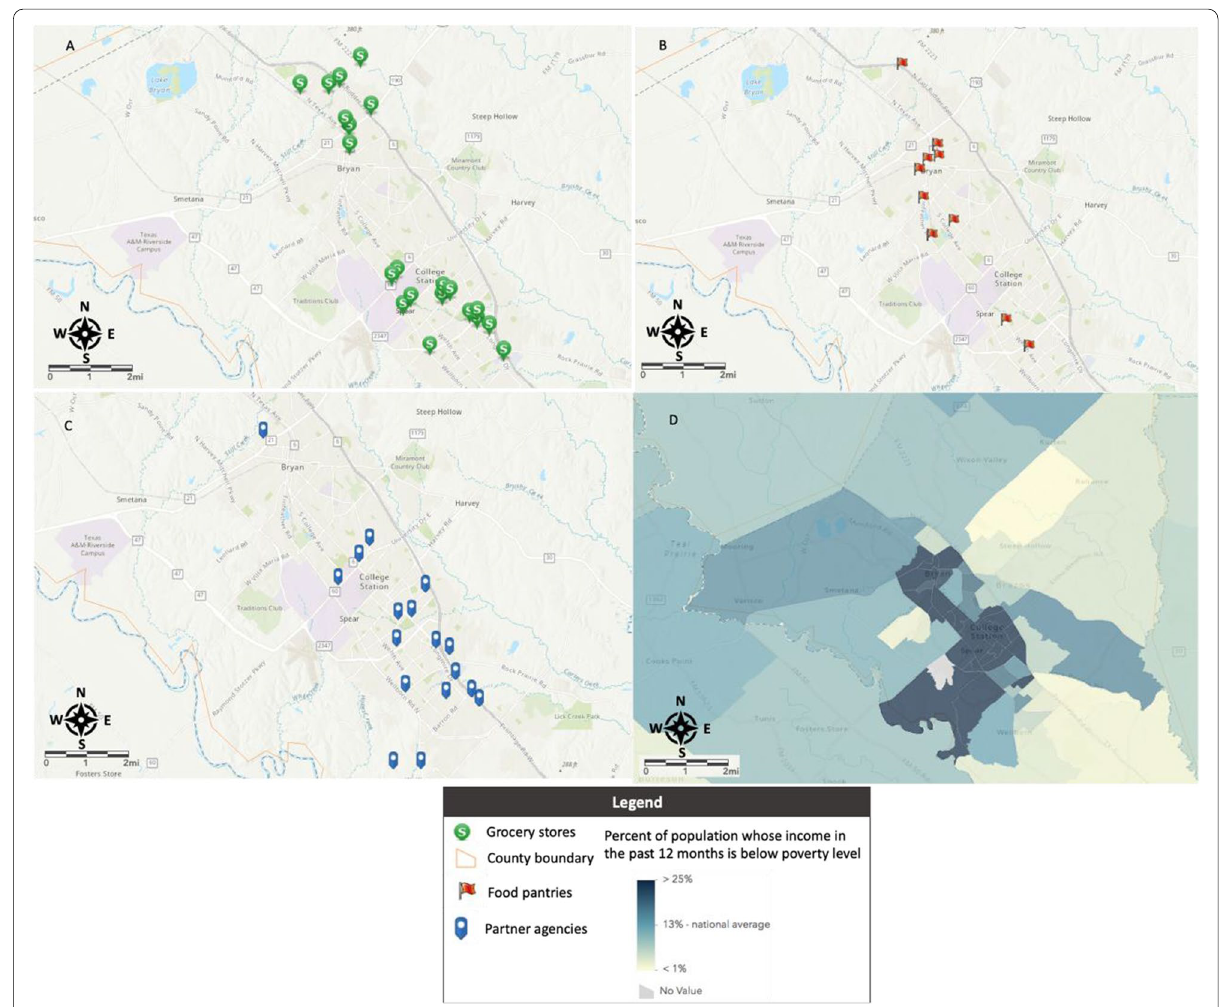
Fig. 2 Mapping food resources and poverty in Brazos